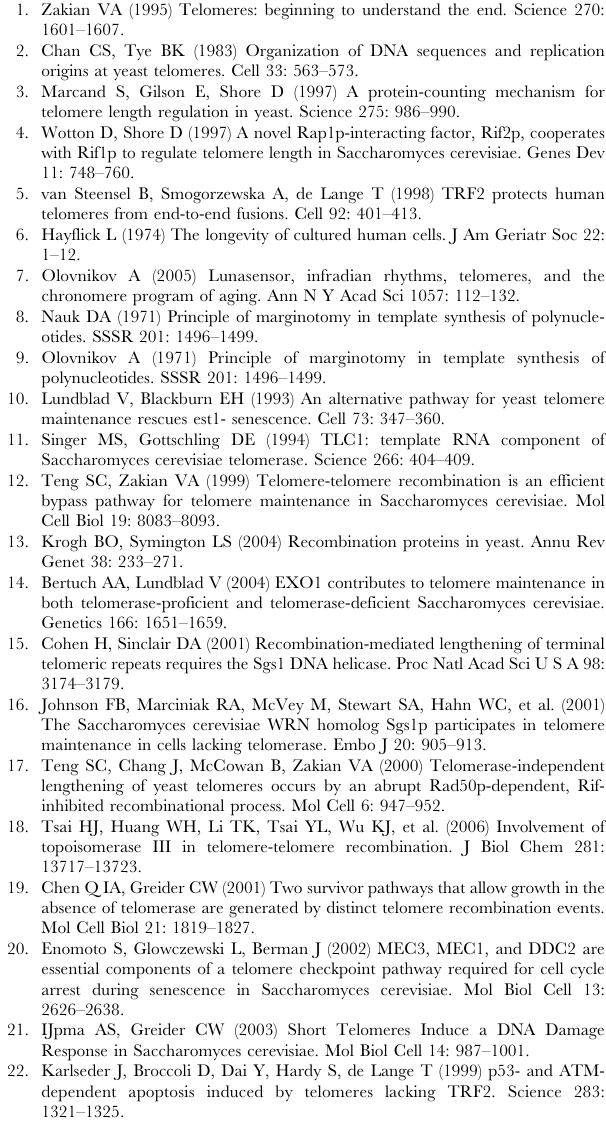
Figure S5 Rad53 phosphorylation and the sensitivity to bleomycin of type I survivors is mainly dependent on Mec1.